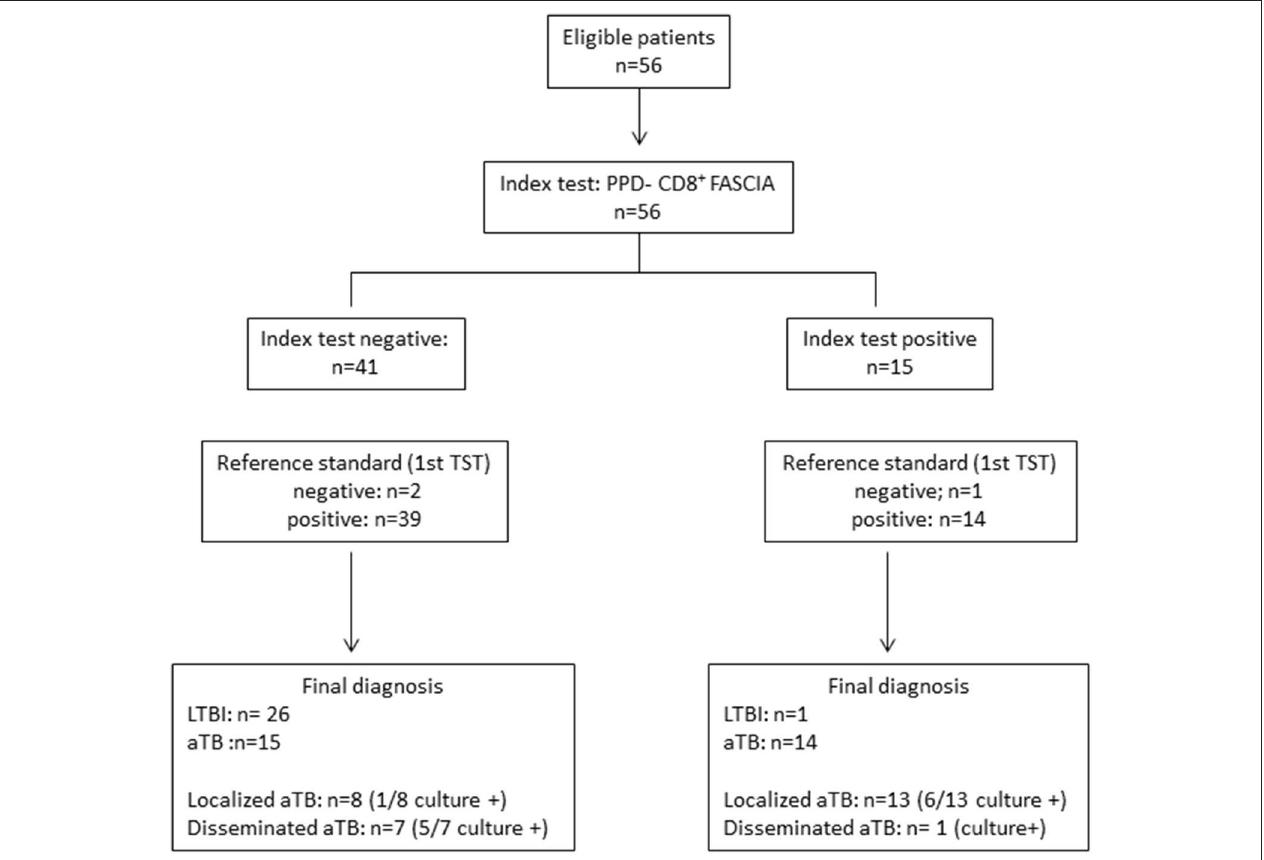
FIGURE 5 | STARD diagram reporting the flow of M. tuberculosis- infected children (LTBI/aTB) for the evaluation of the PPD-induced CD8 + blasts lymphocytes for the identification of children with aTB on the one hand and those with LTBI on the other hand. The reference standard test was the tuberculin skin test (TST) performed in a first diagnostic stage at the time of inclusion in the study. This diagram reports results obtained for the 56 M. tuberculosis -infected children (LTBI/aTB) detected by the combined HBHA- and CFP-10-induced CD3 + FASCIA as reported in Figure 1